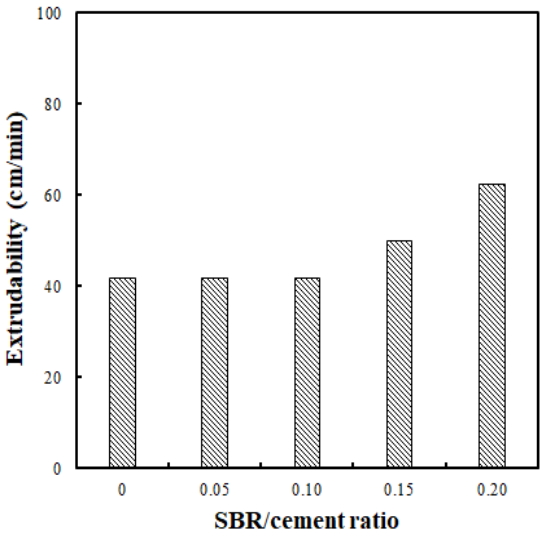
Figure 7. Extrudability comparison for different SBR/cement ratios.